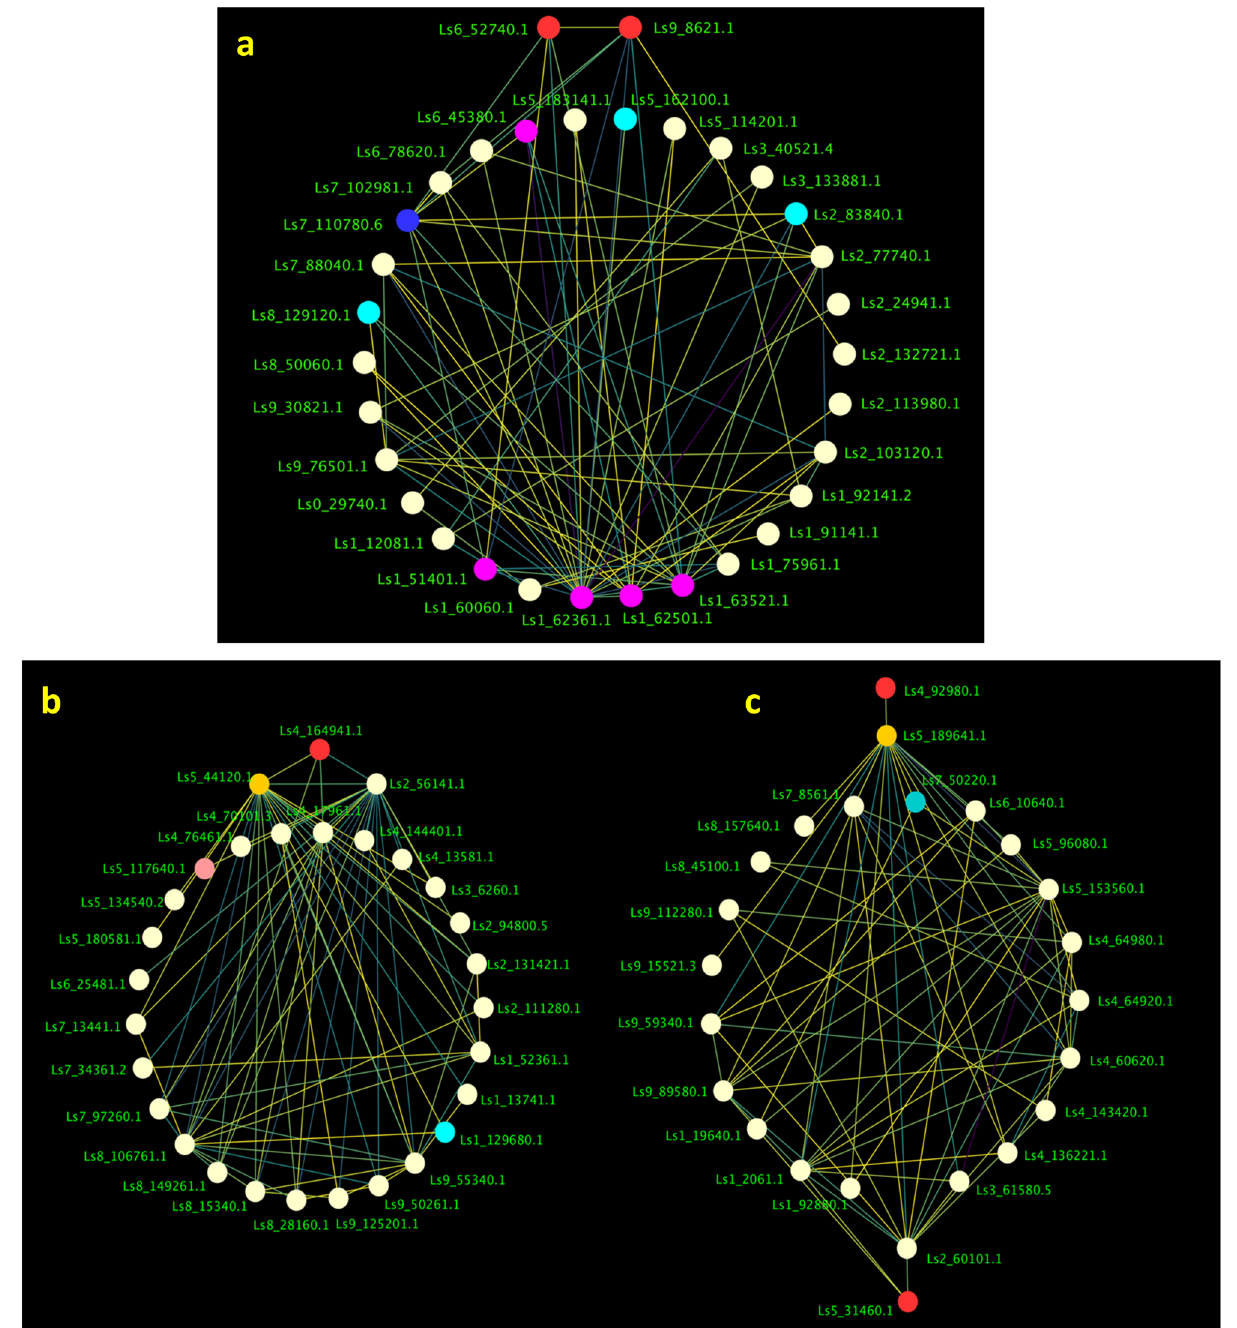
Figure 9. The co-expression network of highly correlated ( r 2 > .90) hub genes and associated TFs identified by applying the Molecular Complex Detection (MCODE) to the networks. ( a ) The co-expression network of the significant genes in the lightgreen module. ( b , c ). Two co-expression clusters of the significant genes in the blue module. The TFs in each cluster are red